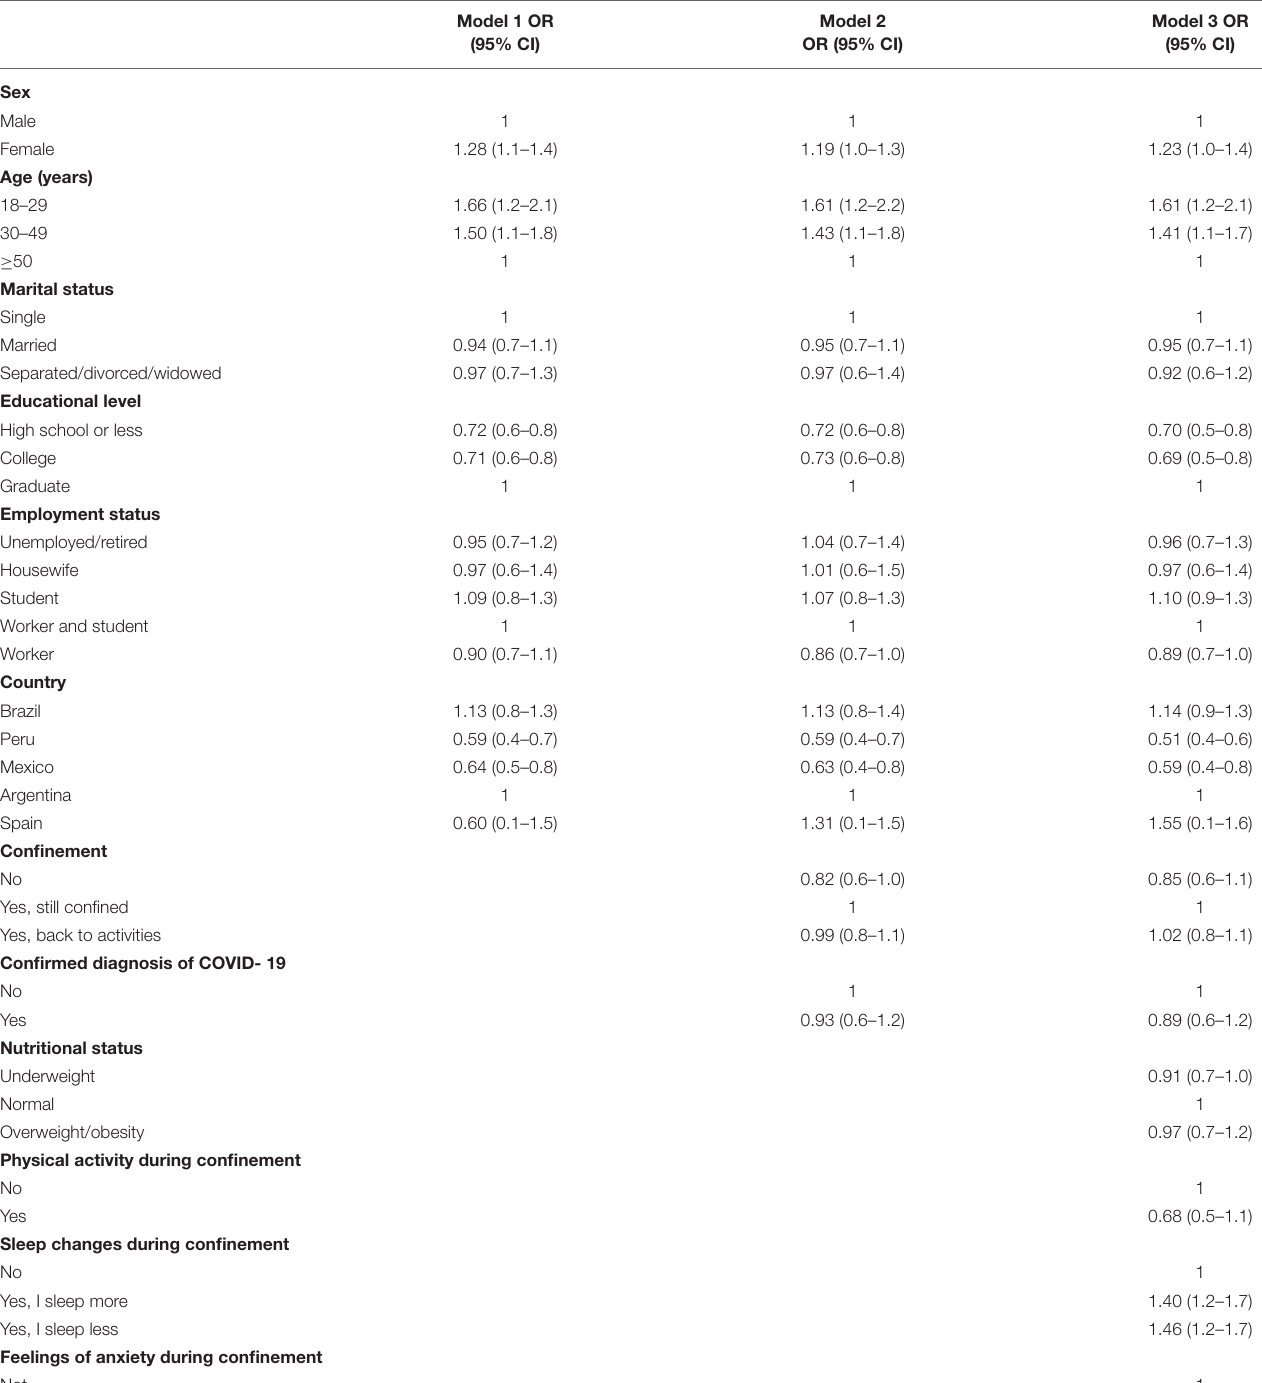
TABLE 3 | Comparison of socio-demographic and selected variables among participants who changed their eating patterns toward healthier choices during the COVID-19 pandemic ( n = 1,435). a .